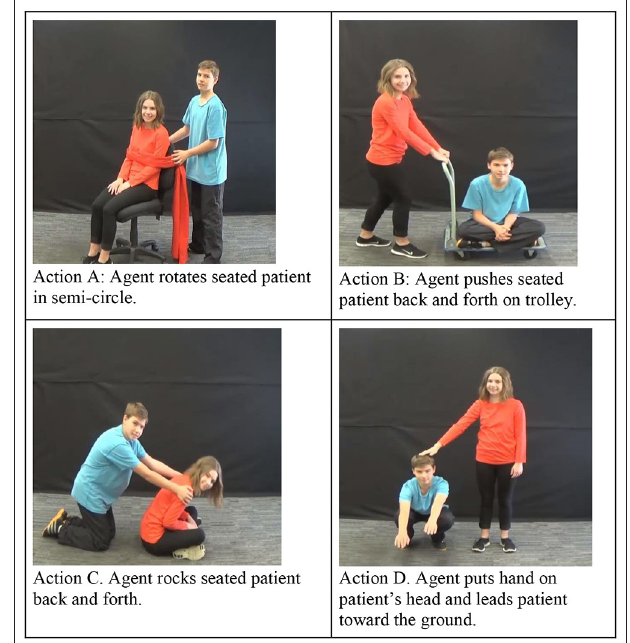
FIGURE 3 | Actions used in the IMPL